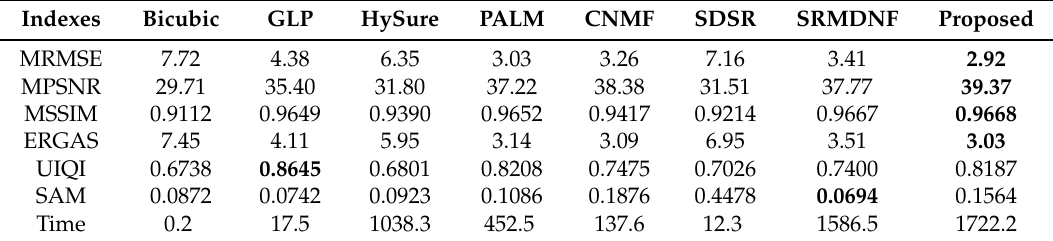
Table 6. Quantitative results on the CAVE dataset with a magnification factor of 4.